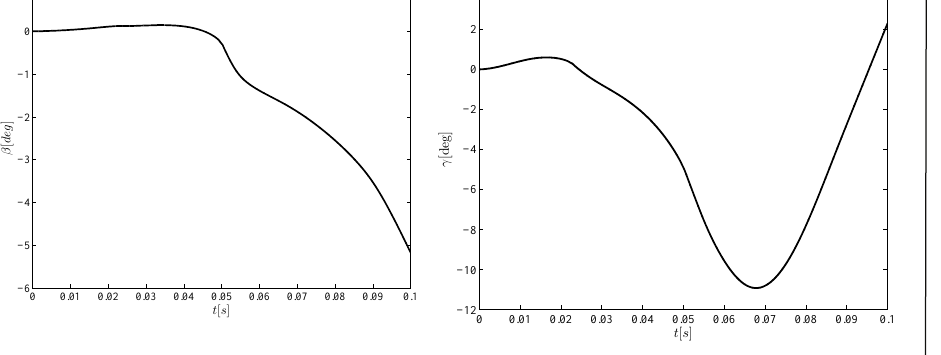
Figure 10  Angle of the bucket rotation of Figure 9  Angle of the arm rotation of the manipulator around the axis the manipulator around the axis yO of the 44 joint in the end of the boom -  joint in the end of the arm -  Рис . 10 – Угол вращения